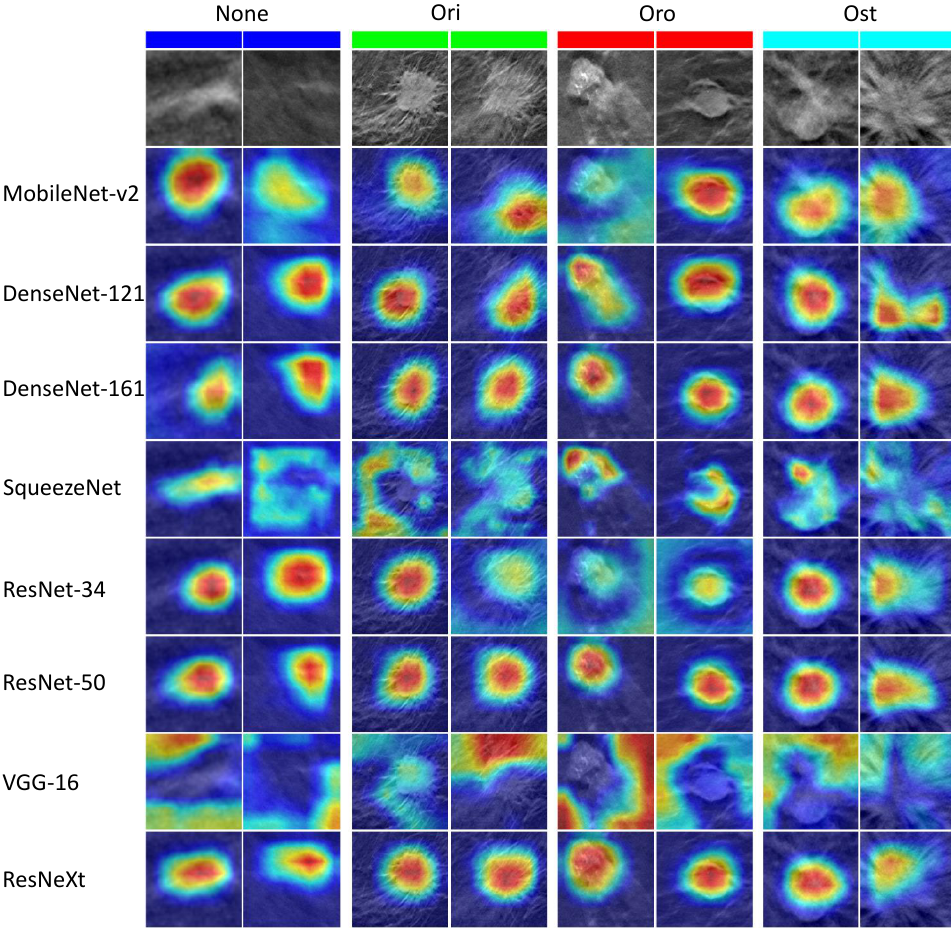
Figure 11. The visualization of the Grad-CAM method with the eight different CNN architectures con- sidered throughout the study. To illustrate the better view, two examples for each class are portrayed, and the ground truth class label is provided above the set of each image. As the jet color scheme is employed for depicting saliency zones, the red color represents the higher intensity, i.e., pixels on which the network is focusing more for performing the classification, whereas the tendency towards the blue color represents the lower intensity of focus. The header bar is used to distinguish among several classes and is colored uniquely. The similar color of header for two images represents the samples chosen from the same